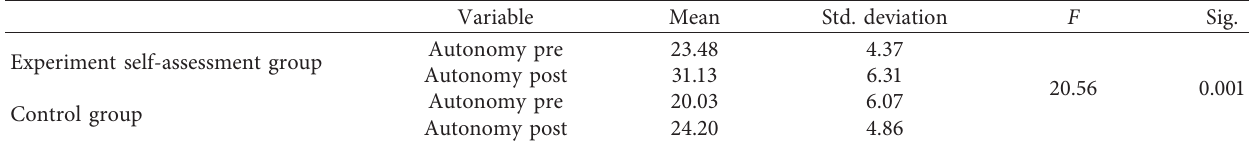
Table 1: Results of covariance for autonomy variable in self-assessment group.